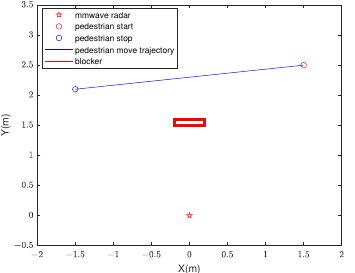
Figure 10. Experiment environment sketch